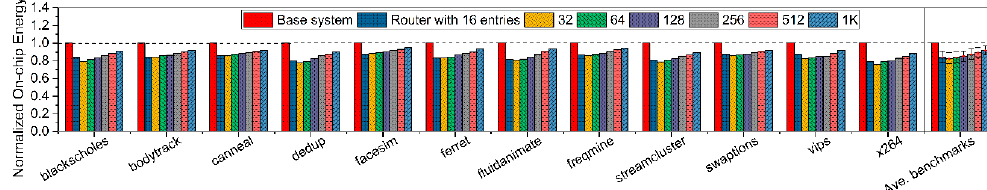
Figure 11. Normalized on-chip energy of proposed router-integrated system with different history buffer scales ranging from 16 to 1K entries.